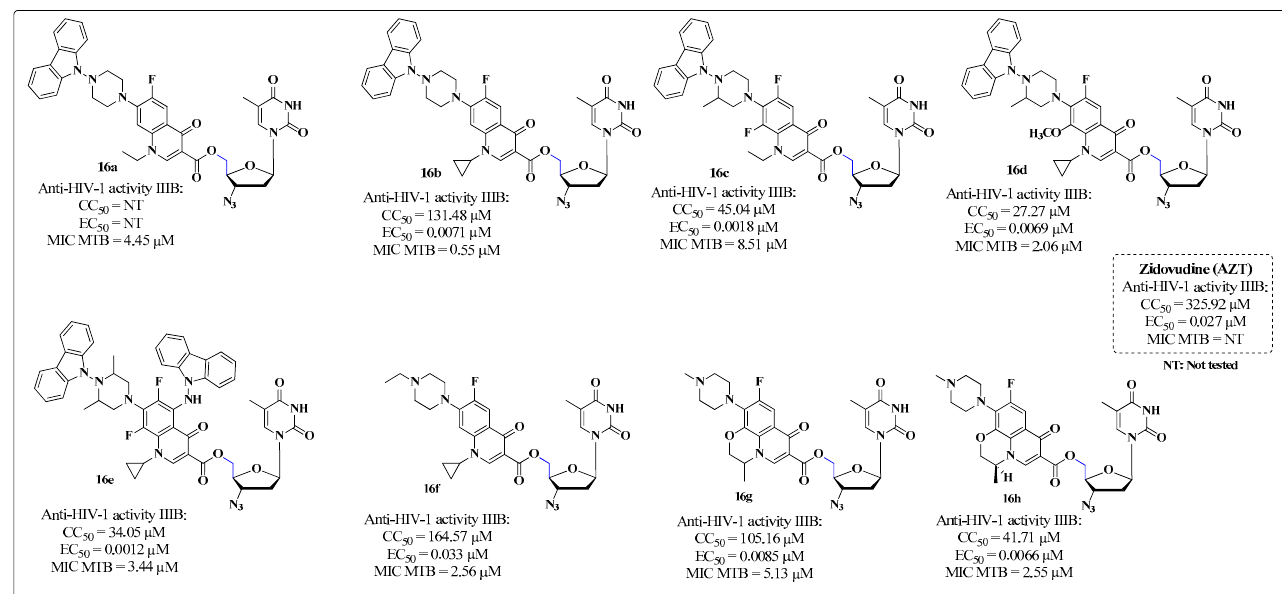
Figure 14. Anti-HIV and anti-MTB activities of EFV derivatives 15a – d [93].